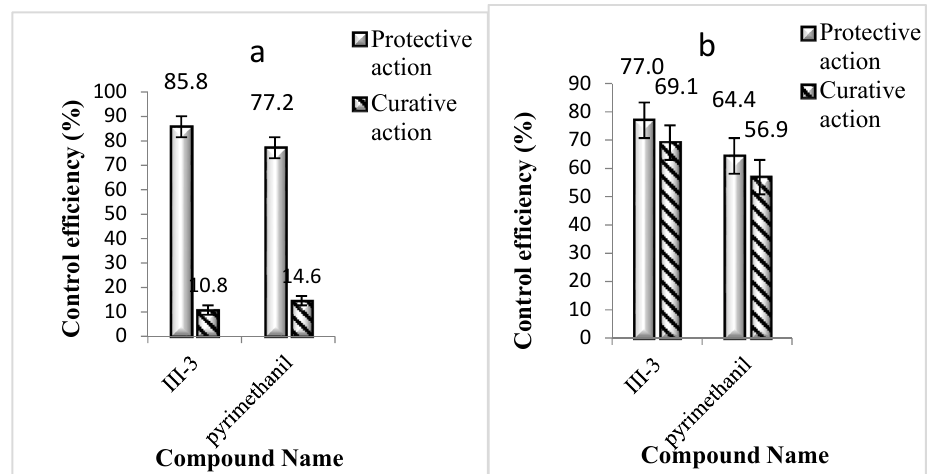
Figure 7 . Control efficiency of compound III-3 against B. cinerea ( a ) Control efficiency of compound III-3 against B. cinerea on leaves of cucumber (spore inoculation method ) ; ( b ) control efficiency of compound III-3 against B. cinerea on leaves of tomato (spore inoculation method).